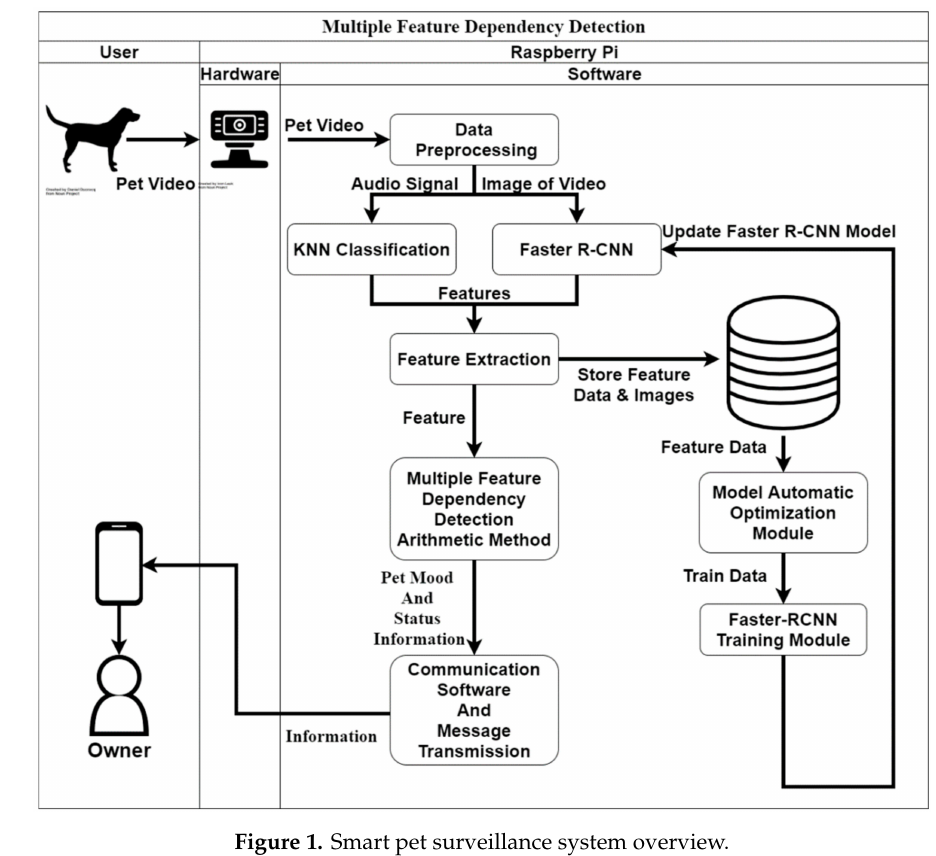
Figure 1. Smart pet surveillance system overview.